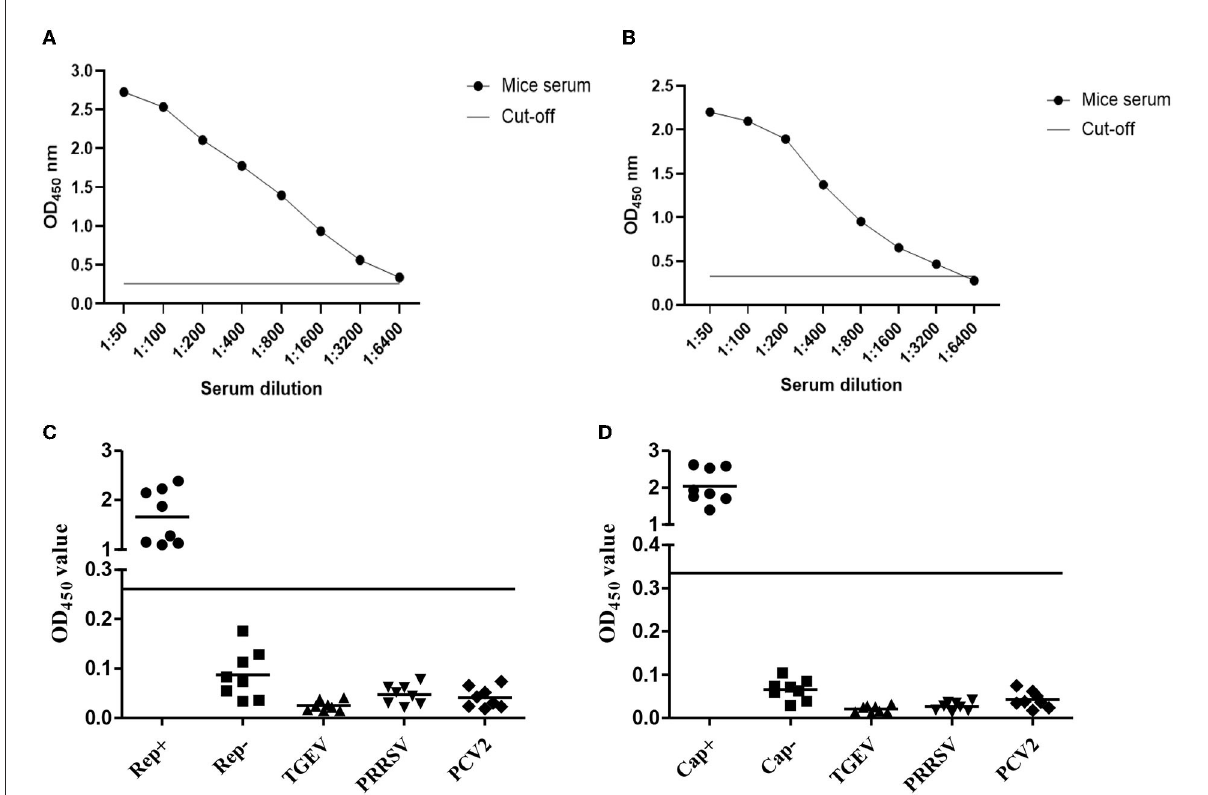
FIGURE4 Sensitivity and specificity analyzing of the indirect ELISA. (A,B) Antibody against Rep protein (A) or against Cap protein (B) diluted from 1:50 to 1:6,400 was individually used to test the sensitivity of ELISA. (C,D) Eight indicated serum samples were used to analyze the specificity of Rep-based (C) and Cap-based (D) ELISA. The OD 450 value higher than the value of black line was recorded as positive, if not,